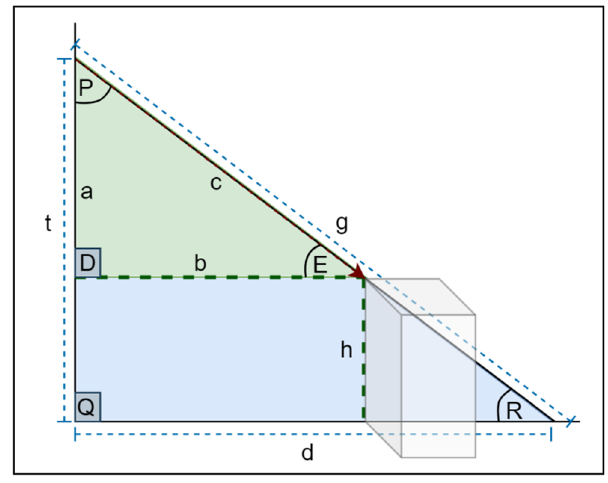
Figure 11. Obstacle Height.